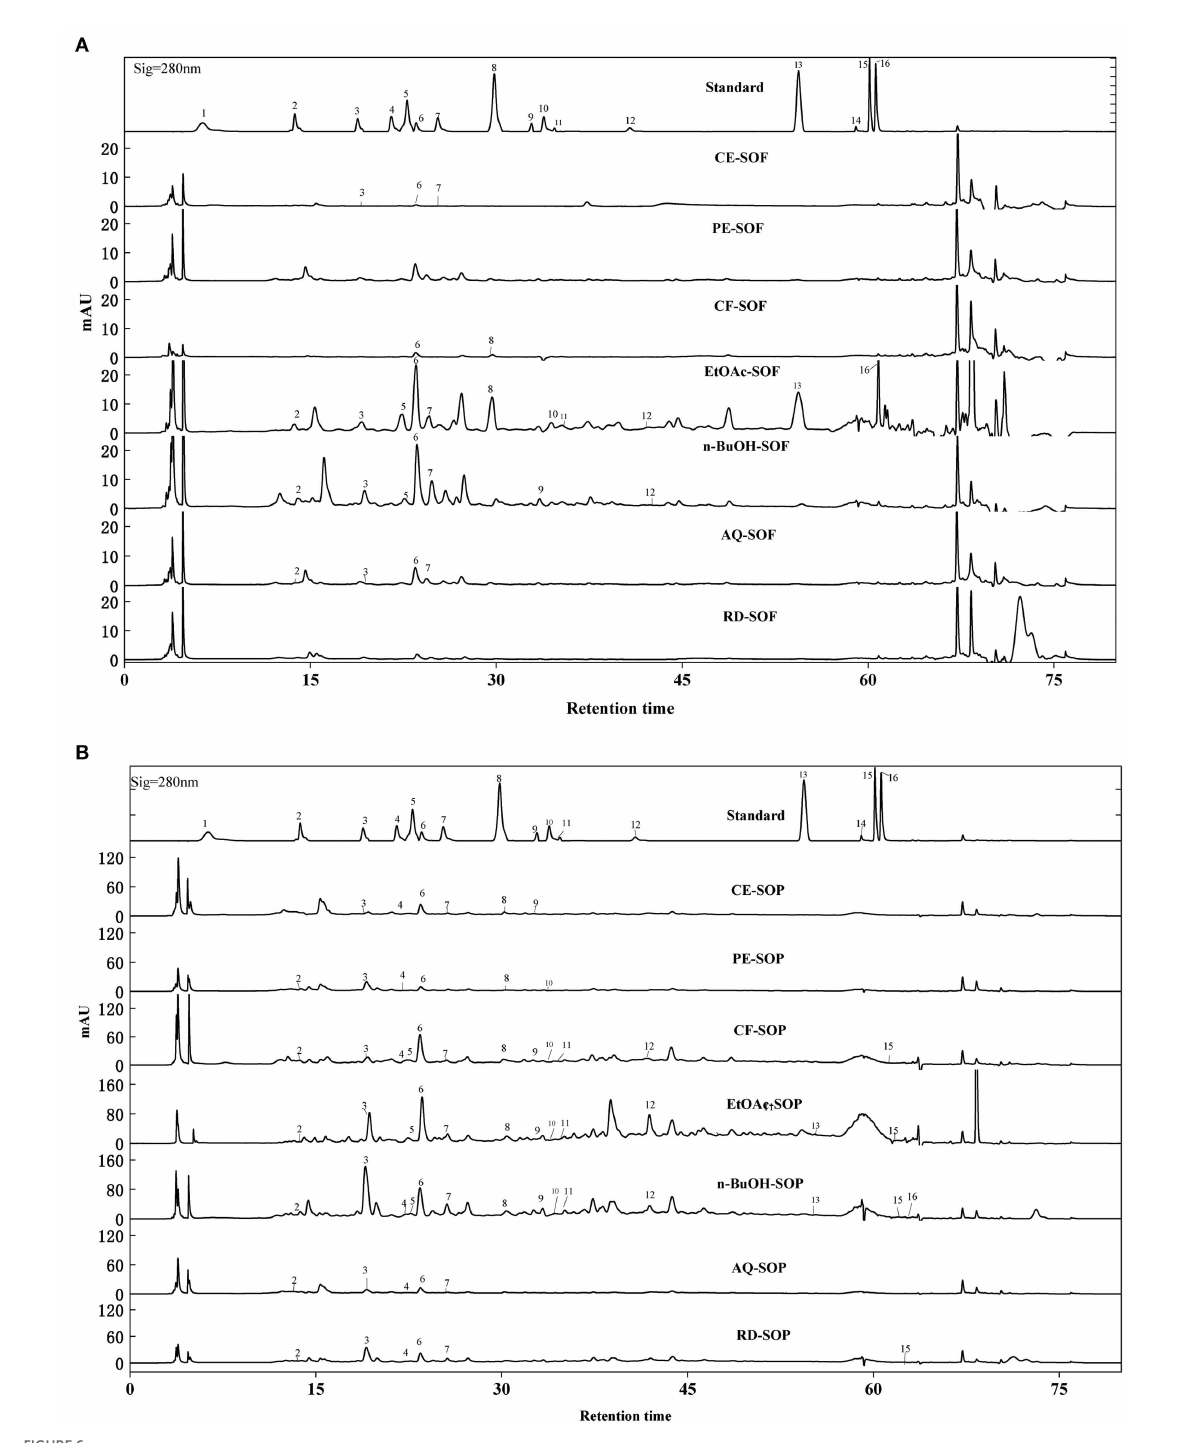
FIGURE6 HPLC-DAD chromatogram of SOEs. (A) The HPLC chromatogram of SOF extraction phase. (B) The HPLC chromatogram of SOP extraction phase. SOEs, Stauntonia obovatifoliola extracts; SOF, Stauntonia obovatifoliola flesh; SOP, Stauntonia obovatifoliola pericarp; mAU, milli-arbitrary units. Detection at 280 nm: (1) Gallic acid, (2) Protocatechuic acid, (3) P-hydroxybenzoic acid, (4) Vanillic acid, (5) Syringic acid, (6) Epicatechin, (7) Dihydromyricetin, (8) Syringaldehyde, (9) Ferulic acid, (10) Epigallocatechin gallate, (11) Ellagic acid, (12) Salicylic acid, (13) Cinnamic acid, (14) Apigenin, (15) Hesperetin, (16) Scutellarin. CE, crude extract; PE, Petroleum ether fraction; CF, chloroform fraction; EtOAc, ethyl acetate fraction; n-BuOH, n-Butanol fraction; AQ, aqueous phase residue; RD,